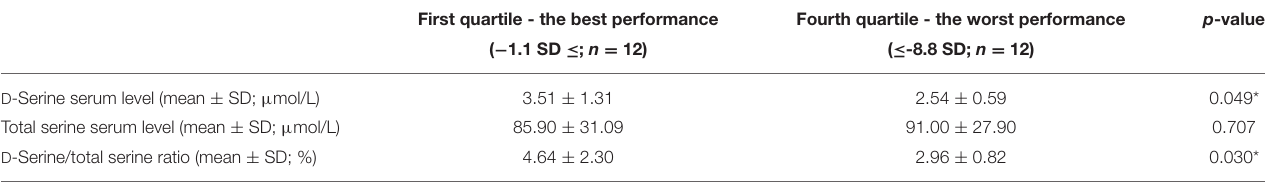
TABLE 7 | Amino acid serum levels—differences between the first and fourth quartiles of the patients’ population ( n = 50) divided into groups according to performance in executive functions testing, summary index 2. First quartile - the best performance Fourth quartile - the worst performance p